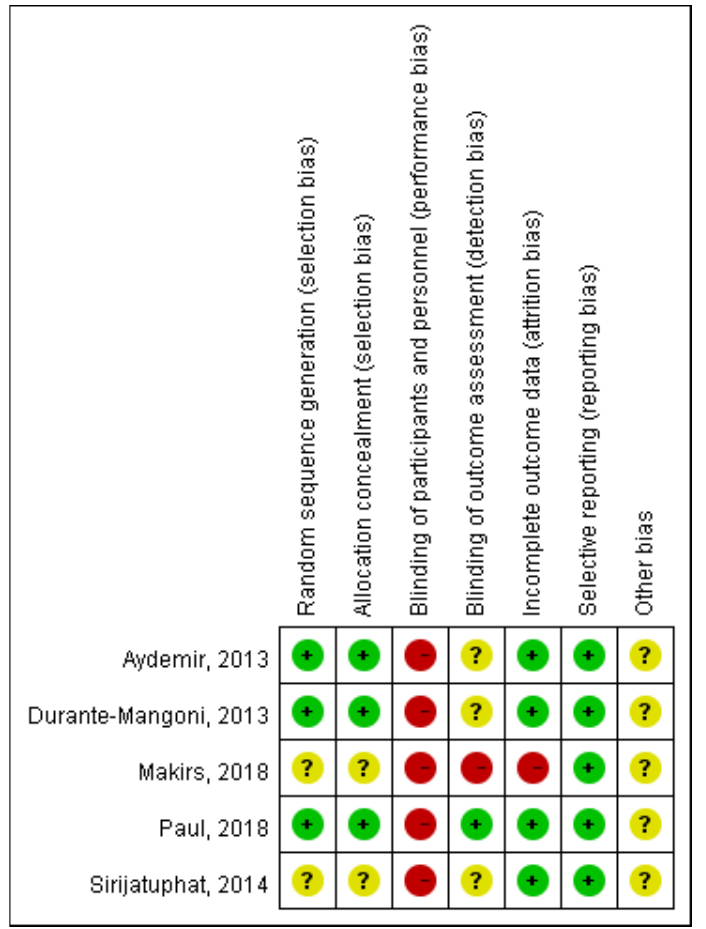
Figure 2. Summary of risk of bias.